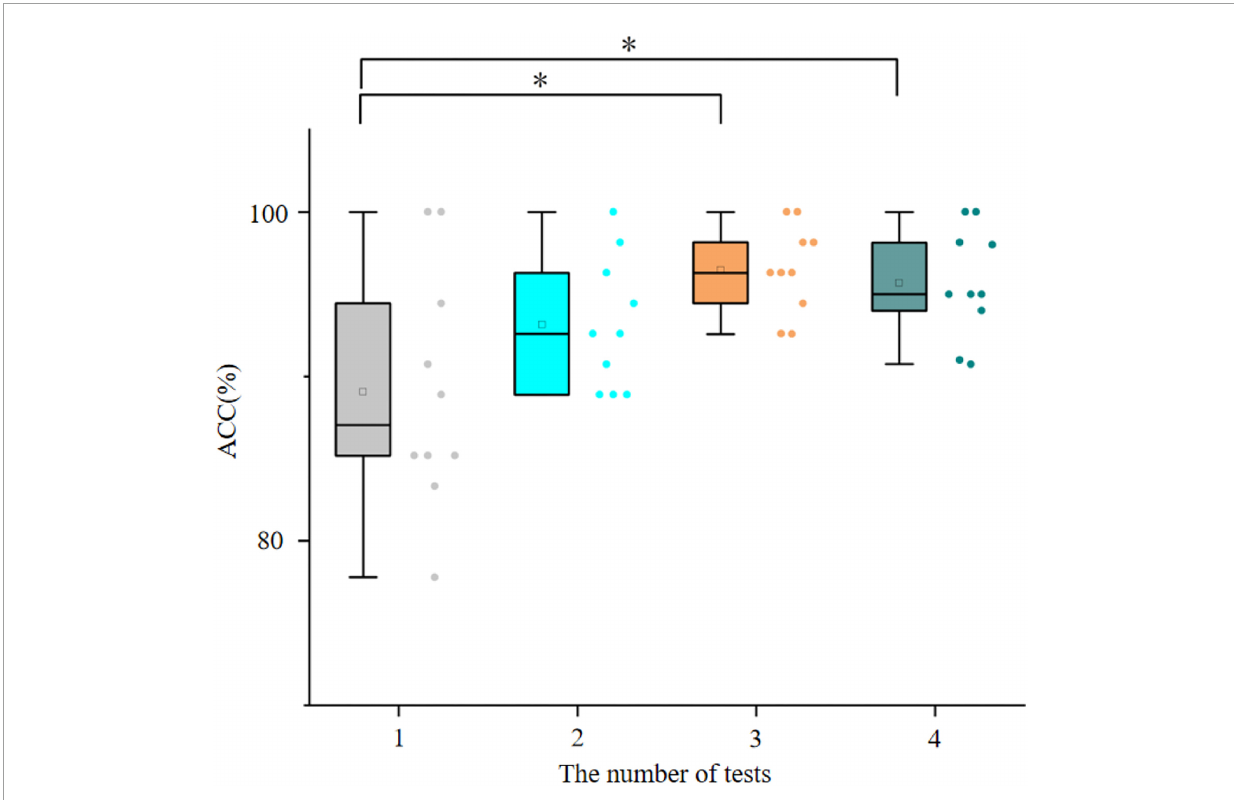
FIGURE6 The accuracy of the hybrid speller with the number of tests in the online tests. Asterisk represents a significant difference ( p < 0.05), 1–3 are the copy speller tests, and 4 is the free spelling